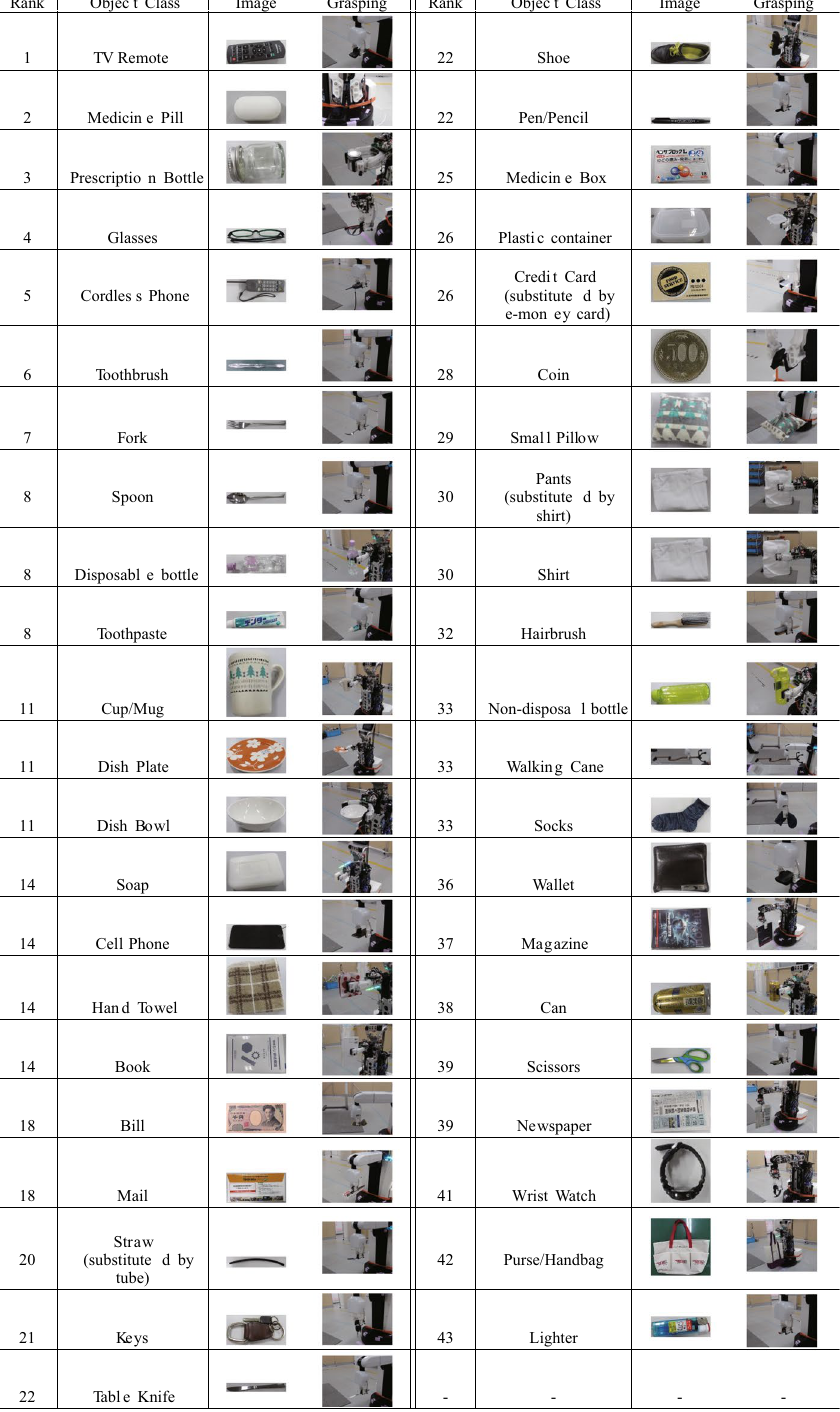
Table 2 List of objects in [20] and pictures of